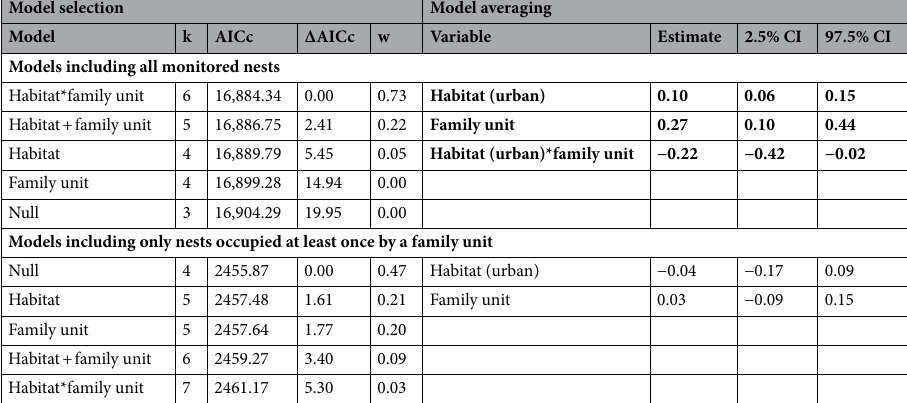
Table 3. Models obtained to assess the effects of family units on the annual productivity of urban and rural burrowing owls Athene cunicularia . Estimates and 95% confidence intervals (2.5% and 97.5%) were assessed after model averaging. All models were run including year as a random term and were corrected for zero- inflation; models run to compare the productivity of family units and breeding pairs considering only the set of nests that were at least once occupied by a family unit also included “nest” as a random term. k: number of parameters, AICc: Akaike Information Criterion corrected for small sample sizes, ΔAICc: the difference between the AICc of model i and that of the best model (i.e. the model with the lowest AICc), w: Akaike weights. The fit of the models including all variables used in model averaging can be checked in Fig. S5. In bold, variables receiving strong support (i.e., the 95% confidence interval did not overlap with zero).